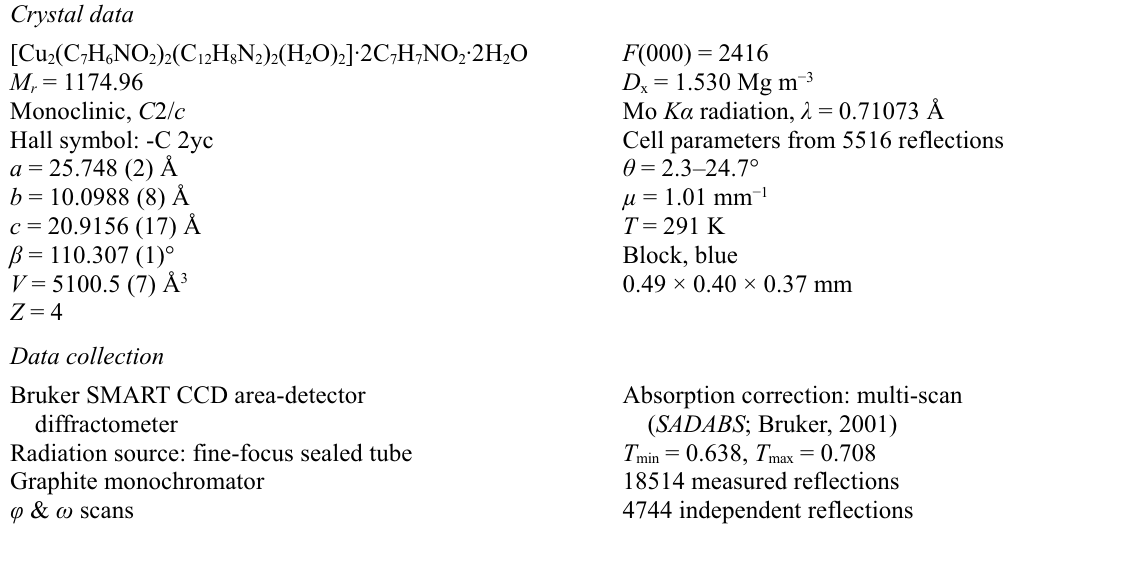
Projection of the unit cell showing the three-dimensional structure formed by H-bonding interaction of the compound (I). bis( µ -4-aminobenzoato)bis[aqua(1,10-phenanthroline)copper(II)] dichloride bis(4-aminobenzoic acid)